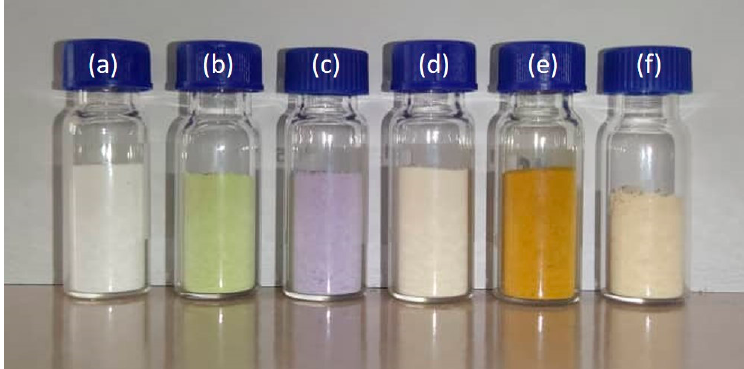
Figure 1. Physical appearance of ( a ) SAPO-5, ( b ) CuCl × /SAPO-5, ( c ) CoCl × /SAPO-5, ( d ) SnCl × /SAPO-5, ( e ) FeCl × /SAPO-5 and ( f ) ZnCl × /SAPO-5. ( e ) FeCl × / SAPO-5 and ( f ) ZnCl × /